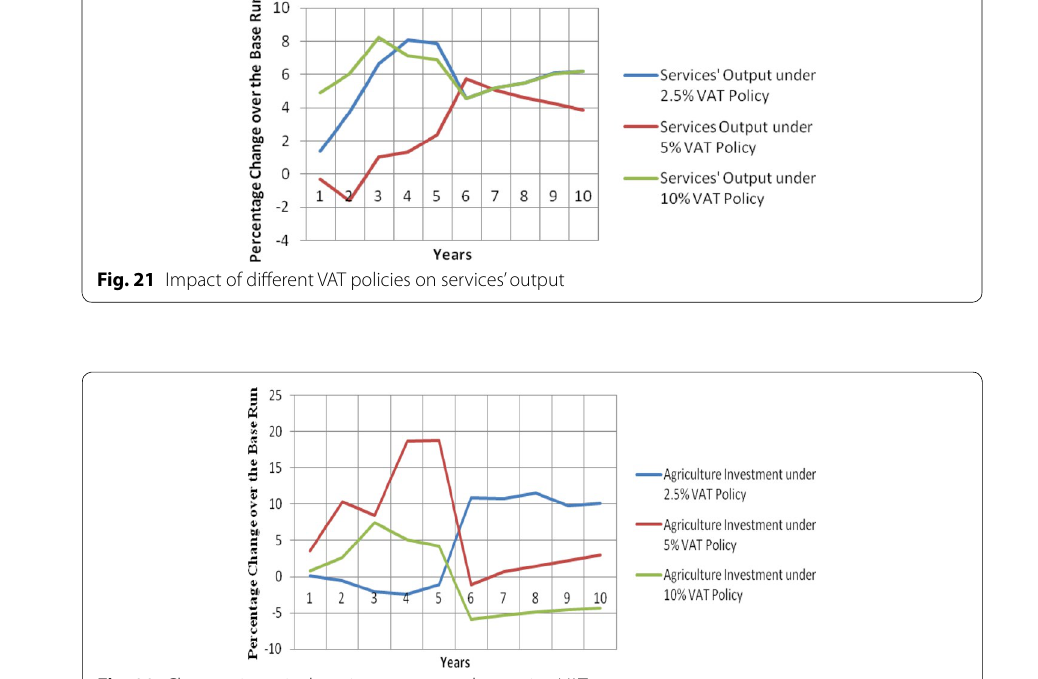
Fig. 22 Changes in agriculture investment under varying VAT